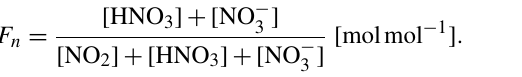
Figure 10. The simulated spatial distribution of (a) SO 2 − NO − represent 40 and 60µgm − 3 . The 72h HYSPLIT backward trajectory from Fukuoka is overlaid with orange lines and orange circles at 3 12h intervals. (Left) 00:00LT on 16 January 2015 when the air mass left China and (right) 00:00LT on 17 January 2015 when the air mass reached